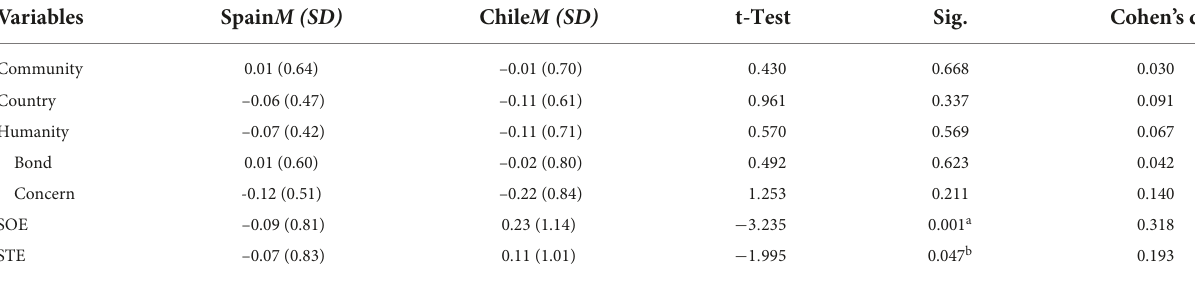
TABLE 5 Means, standard deviations, and t-test among the study variables by country and between time points (T2-T1).